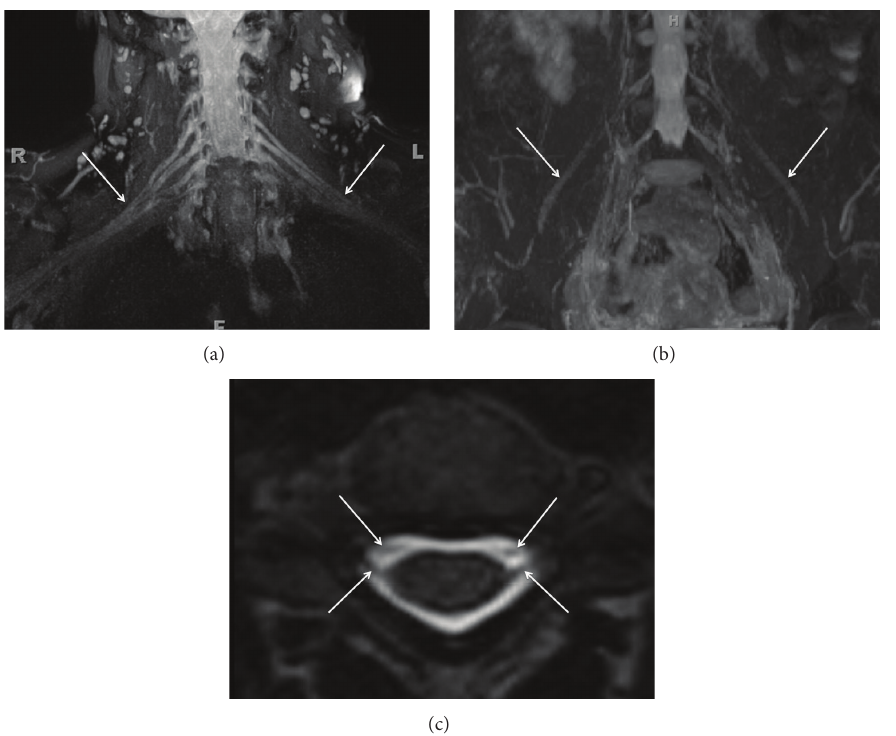
Figure 1: (a) 3D anatomic nonselective MRN-MIP reconstruction from a coronal 3D STIR SPACE sequence shows normal symmetric signal intensity and size of bilateral brachial plexuses (arrows). (b) 3D anatomic nonselective MRN-MIP reconstruction from a coronal 3D STIR SPACE sequence shows normal symmetric signal intensity and size of bilateral LS plexuses and femoral nerves (arrows). (c) 3D anatomic nonselective MRN-Axial reconstruction from 3D T2 SPACE sequence shows the dorsal and ventral roots (preganglionic segments) on both sides (arrows).